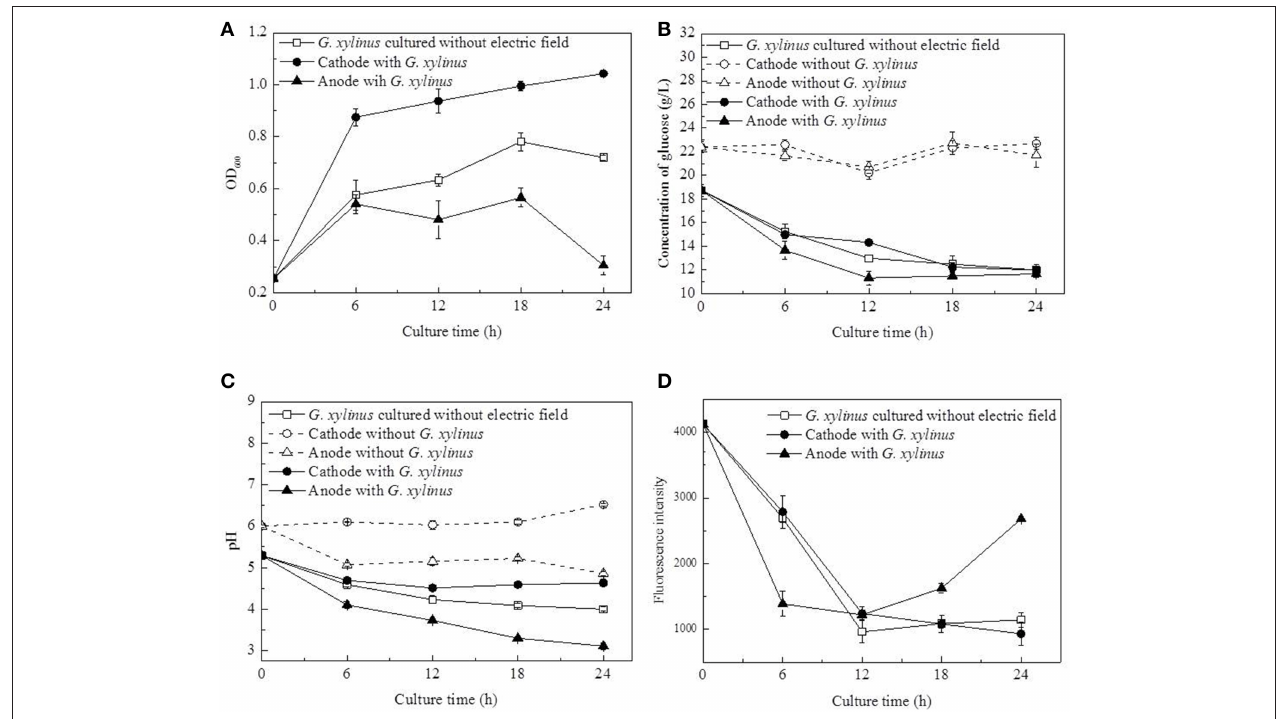
FIGURE 2 | Changes of cell density, pH, glucose concentration, and membrane-disrupting activity of G. xylinus cultured with/without DC electric field. ( A , Cell density; B , Concentration of glucose; C , pH; D , Membrane disrupting activity). Dash lines in (B,C) : electrolysis testing in the fresh medium; Data represent means ± SD from four independent experiments.